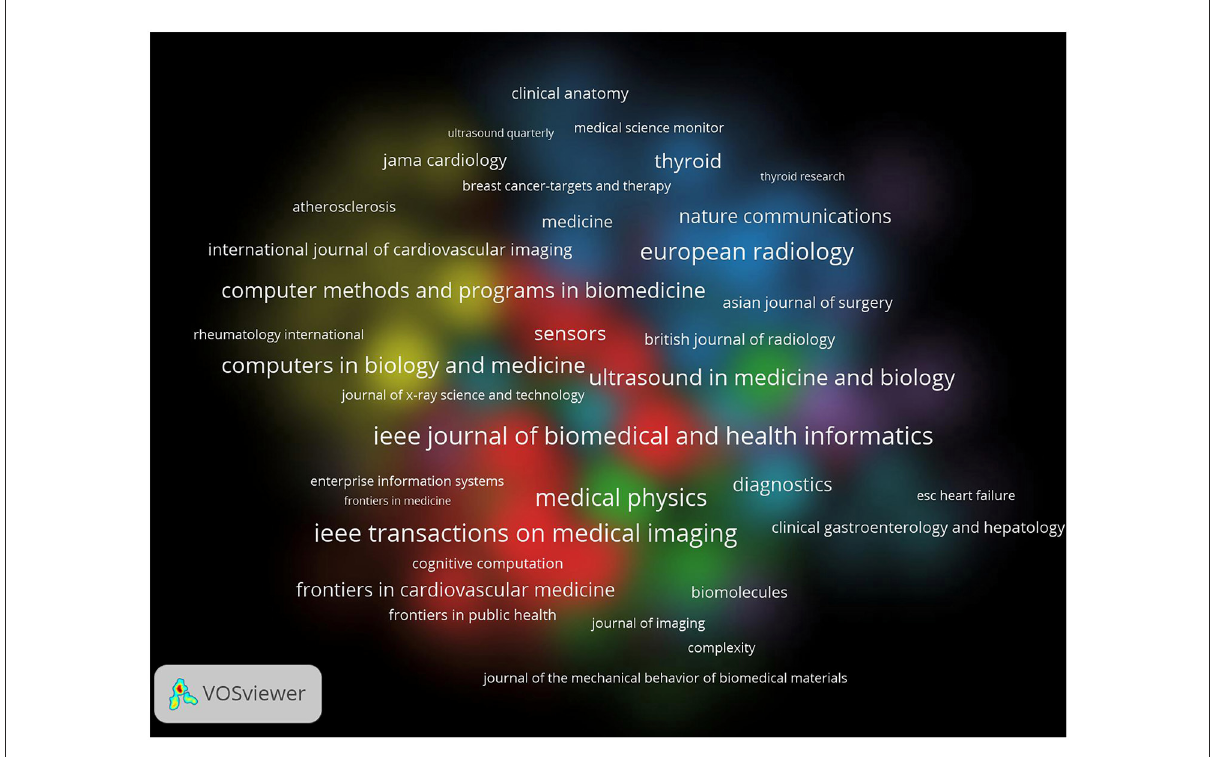
FIGURE9 The network of journals produced in VOSviewer. The size of circles reveals the